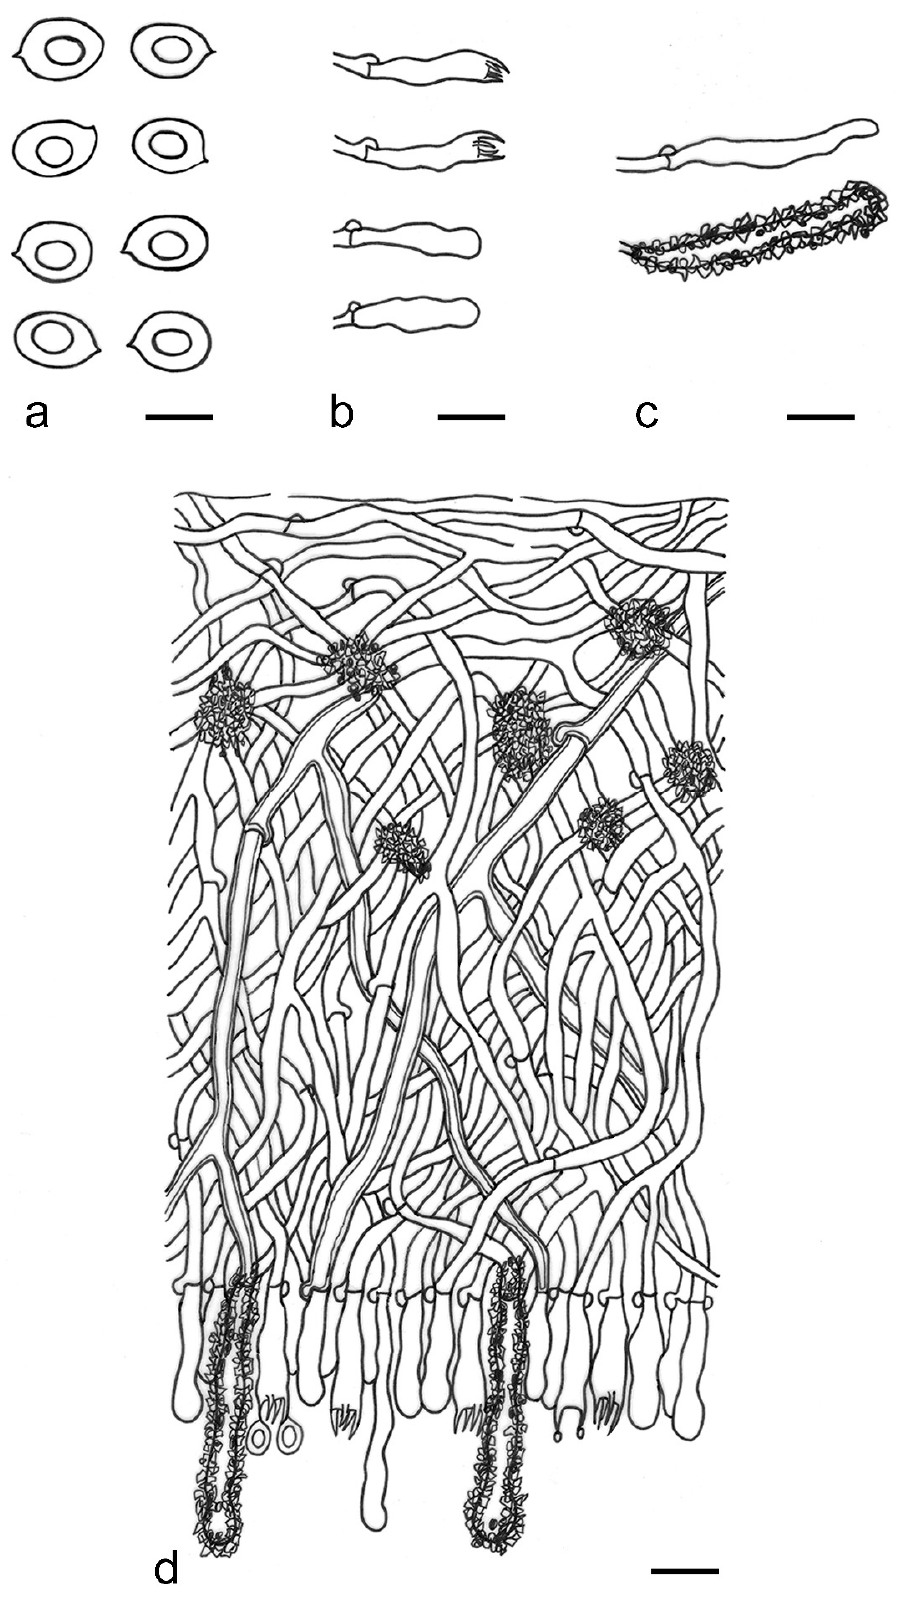
Figure 19. Microscopic structures of Lyomyces leptocystidiatus (drawn from the holotype). ( a ) Basidiospores; ( b ) basidia and basidioles; ( c ) leptocystidia; ( d ) a section of the basidiocarp.—Scale bars: a = 5 μ m; b–d = 10 μ m.